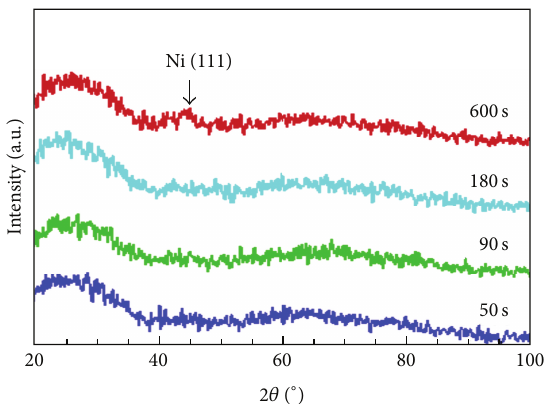
Figure 1: XRD spectra of the C-Ni films as a function of deposition times.